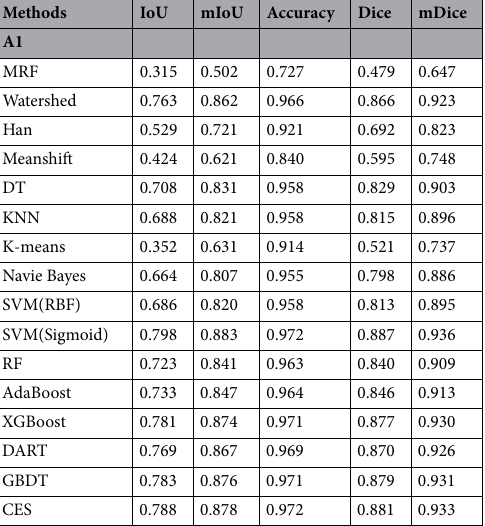
Table 1. The IoU (blue area), mIoU, Accuracy, Dice (blue area) and mDice of Image A1 using other methods and our CES method trained on group B.